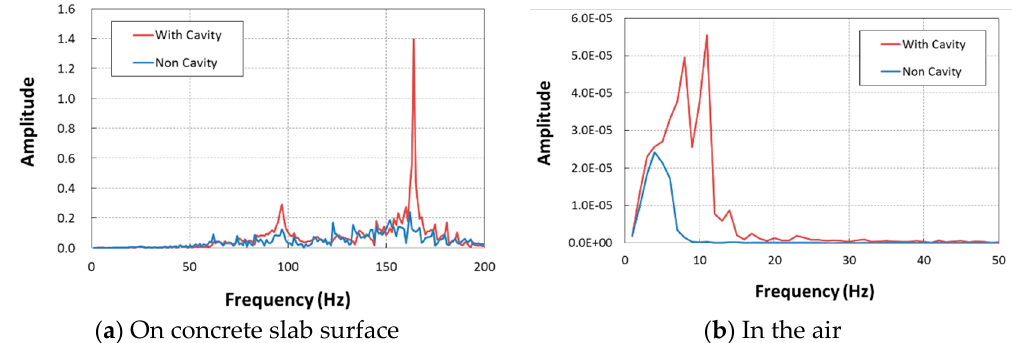
Figure 5. Comparison of acceleration amplitude in frequency domain in cases of with gap and without gap underneath the slab. ( a ) On concrete slab surface. ( b ) In the air.